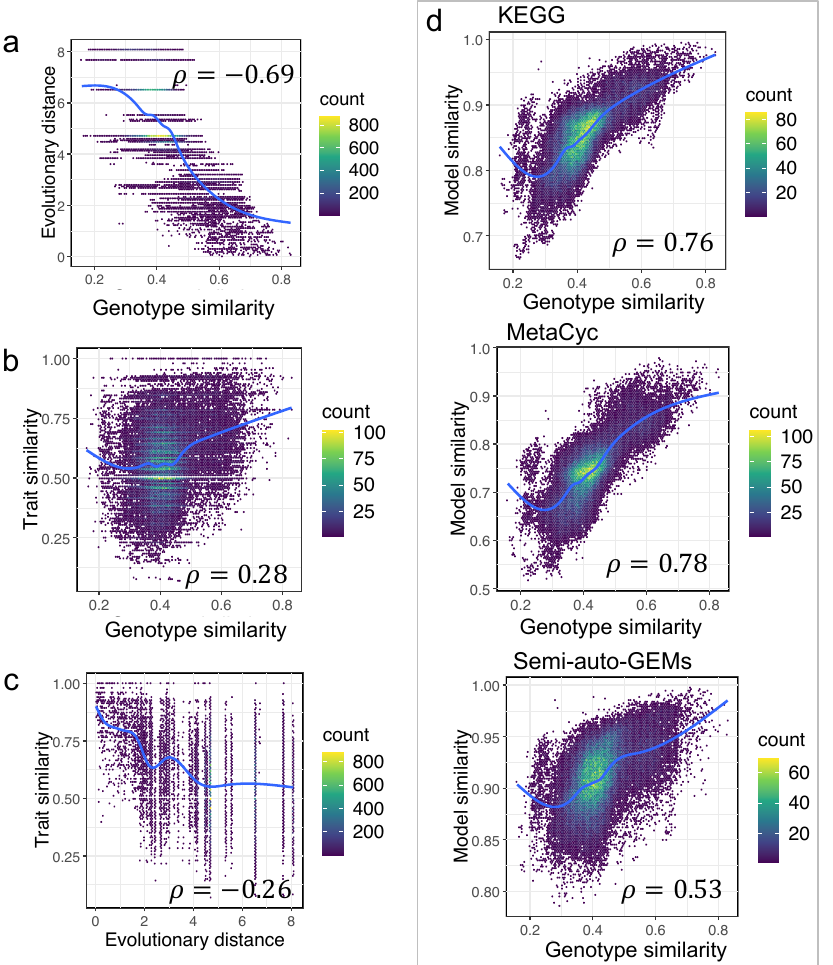
Figure 6. Genotype similarity significantly contributes to model similarity: ( a ) Correlation between genotype similarity and genome evolutionary distance; ( b ) correlation between genotype similarity and trait similarity; ( c ) correlation between evolutionary distance and trait similarity; ( d ) correlation between genotype similarity and model similarity calculated using GEMs of different sources across 332 yeast